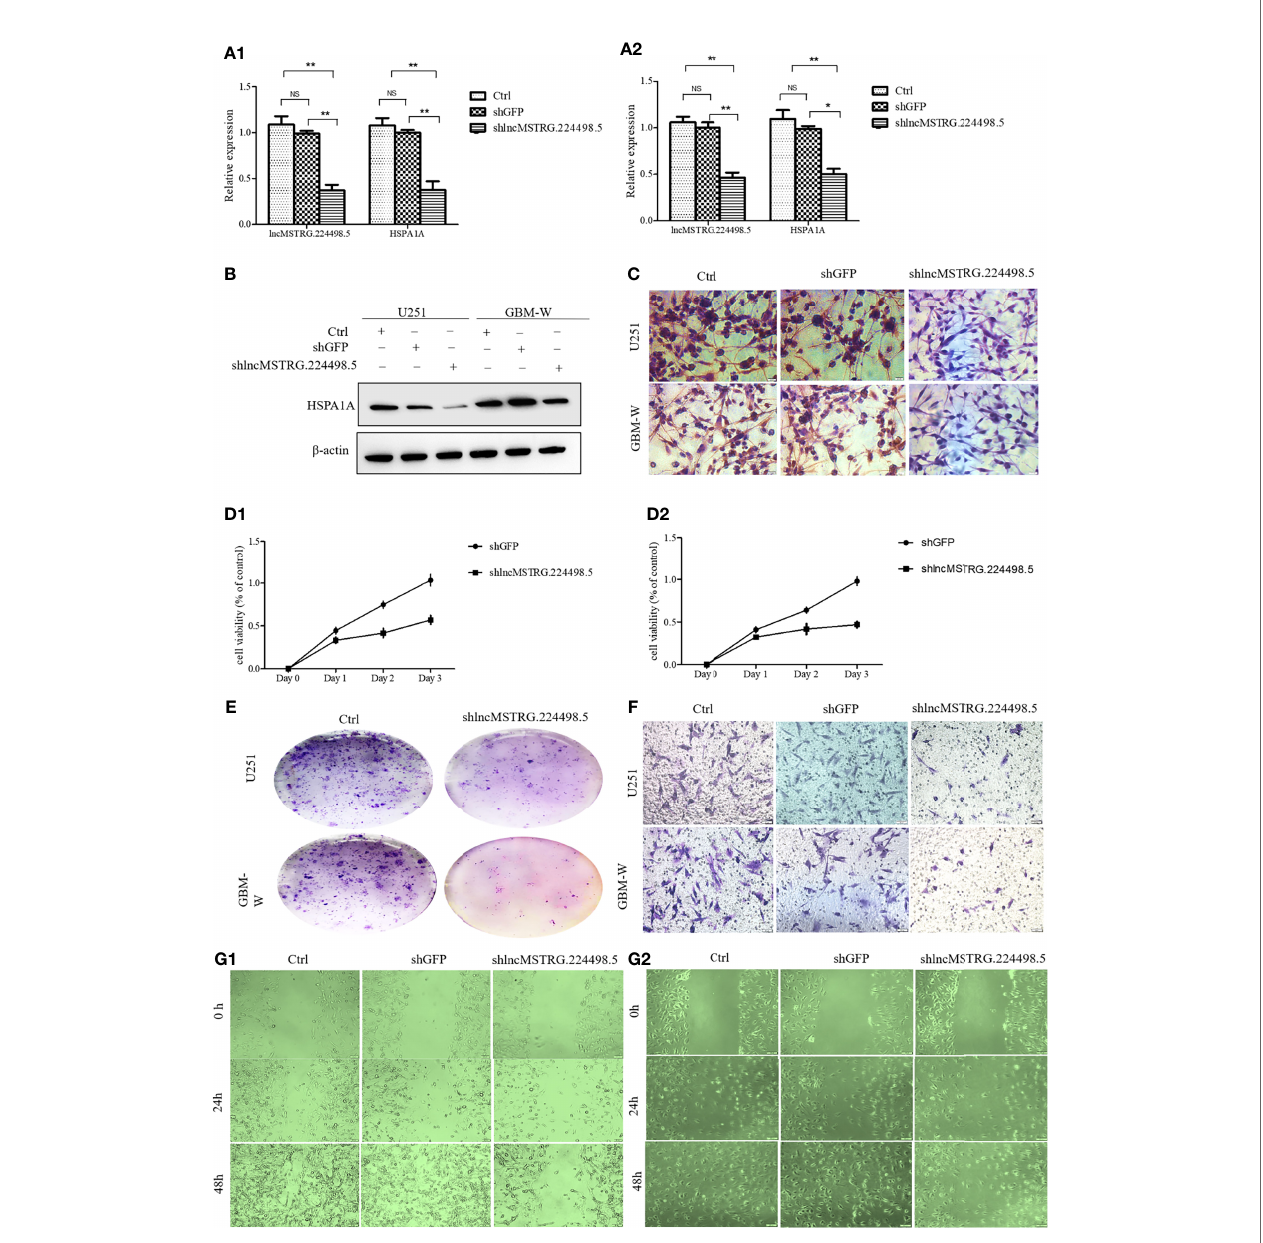
FIGURE 4 | LncRNAs NONHSAT079852.2 can promote the proliferation, invasion and migration of glioma cells. (A) qRT-PCR analysis of HSPA1A in U251(A1) or GBM-W(A2) cells after transfection for 48 hours. (B) Western blot analysis of HSPA1A in U251 or GBM-W cells after transfection for 48 hours. (C) IHC analysis of HSPA1A in U251 or GBM-W cells after transfection for 48 hours. (D) Growth curve of U251(D1) or GBM-W (D2) cells after transfection for 48 hours by CCK8 assay. (E) Proliferation of U251 or GBM-W cells after transfection for two weeks as determined by colony-formation assay. (F) Migration and invasion ability of U251 or GBM-W cells after transfection for 48 hours. (G) Migration of U251(G1) or GBM-W(G2) cells after transfection for 48 hours as detected by wound healing assay. Results were presented as mean ± SD. *p < 0.05, **p < 0.01, NS, not signi fi